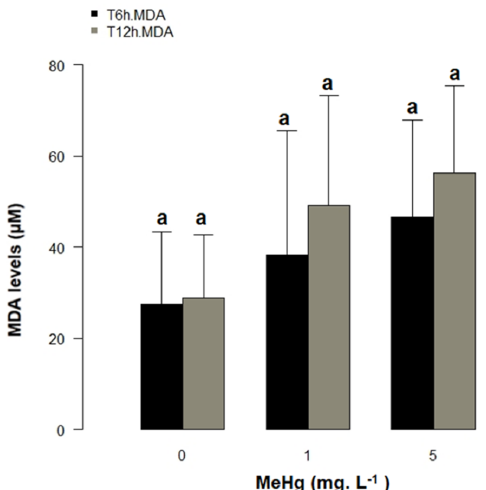
Figure 5. Malondialdehyde (MDA) levels in control (untreated erythrocytes) and in erythrocytes exposed to MeHg at 1 and 5 mg L −1 for 6 and 12 h (mean ± standard error of the mean, n = 5). Differences between treatments were non-significant in all cases ( p > 0.05).